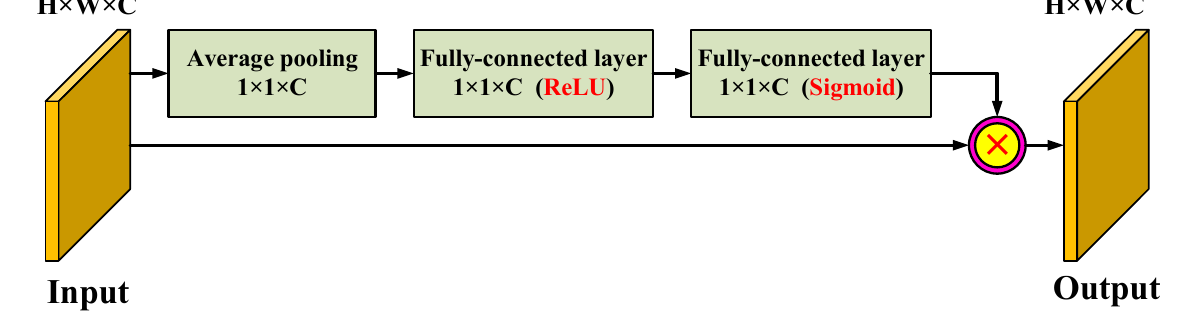
Figure 5. The architecture of the attention mechanism module.